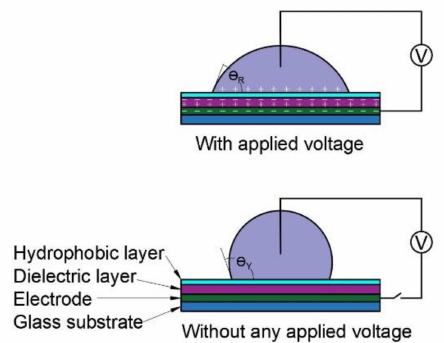
Figure 1. Deformation of drop by